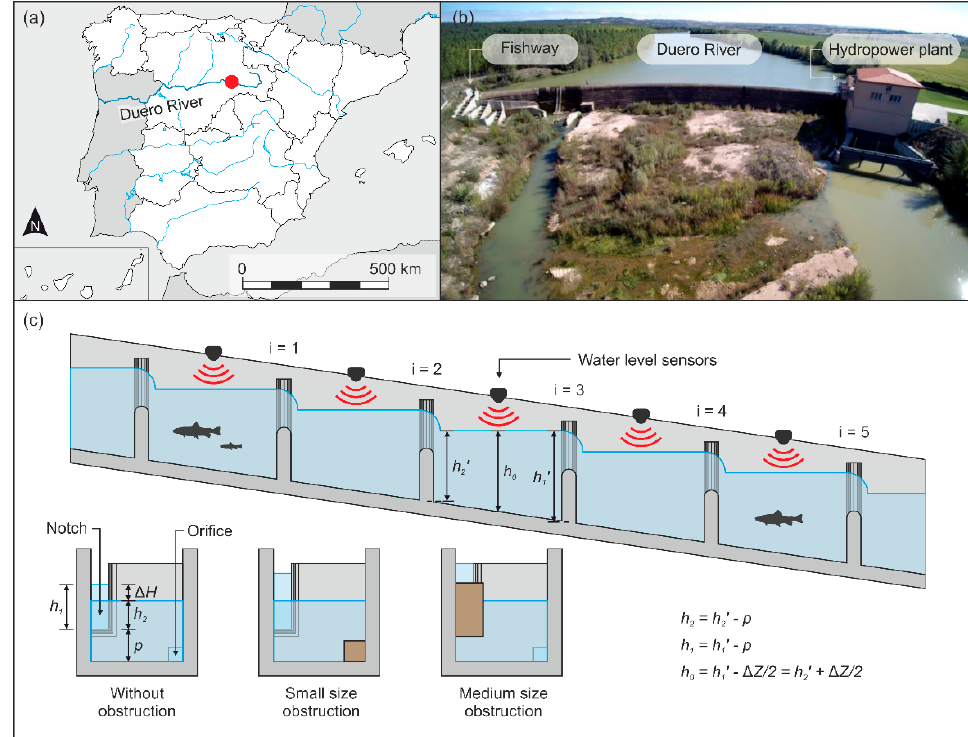
Figure 4. Study case. ( a ) and ( b ) Location. ( c ) Experimental setup.